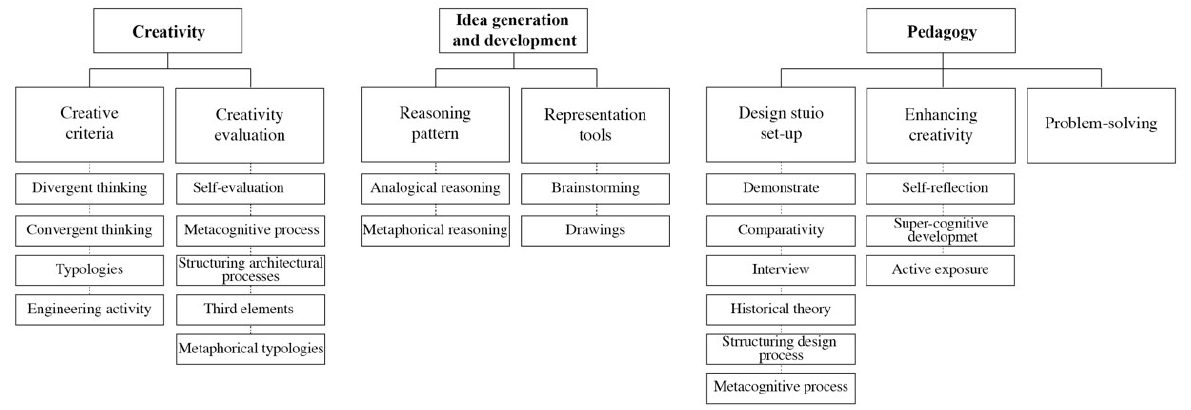
Figure 7. The overall themes and categories of the 36 selected articles .